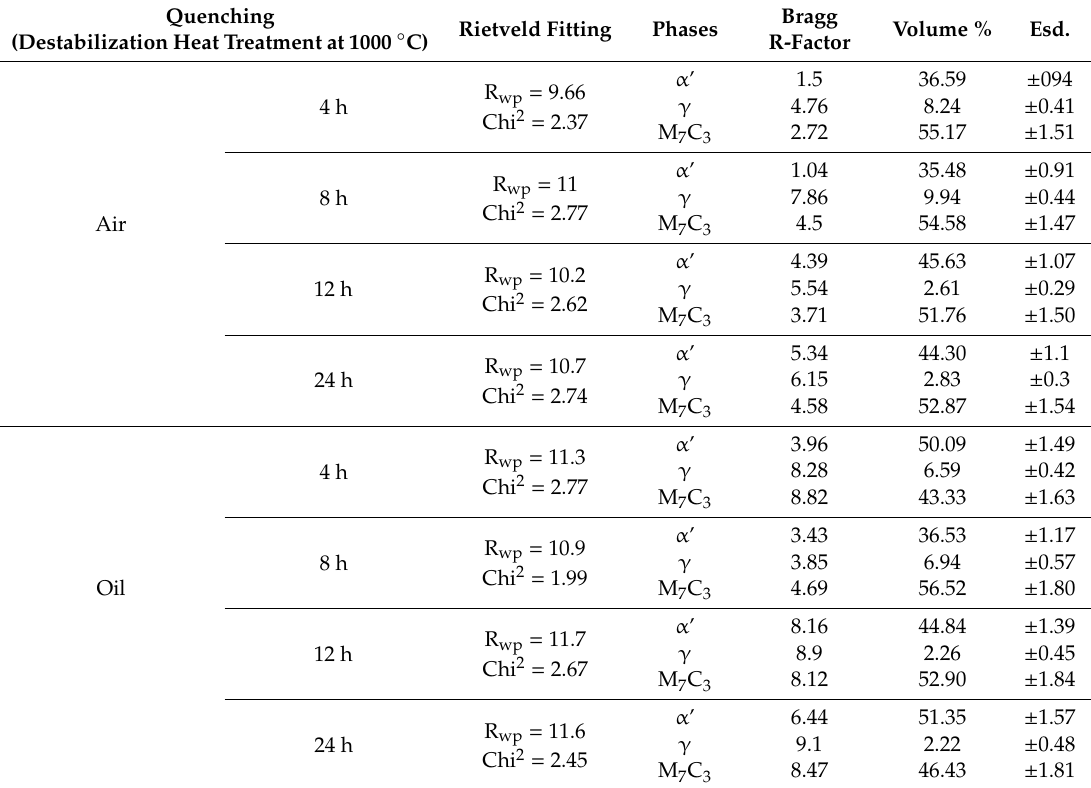
Table 2. Microstructural parameters and weight distributions of the precipitated phases. Esd represents the statistical